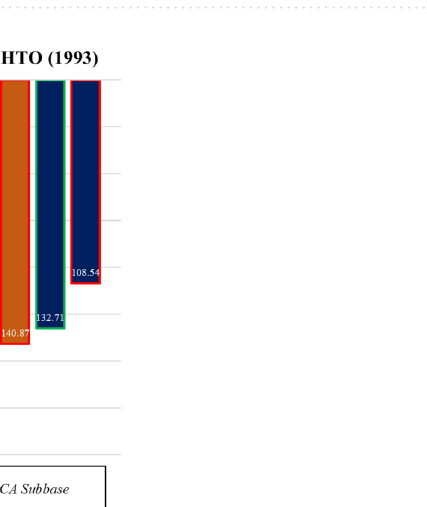
Figure 7. ( a ) Resilient modulus measured versus predicted using AASHTO (1993) model. ( b ) Resilient modulus measured versus predicted using Uzan model. ( c ) Resilient modulus measured versus predicted using MEPD model.